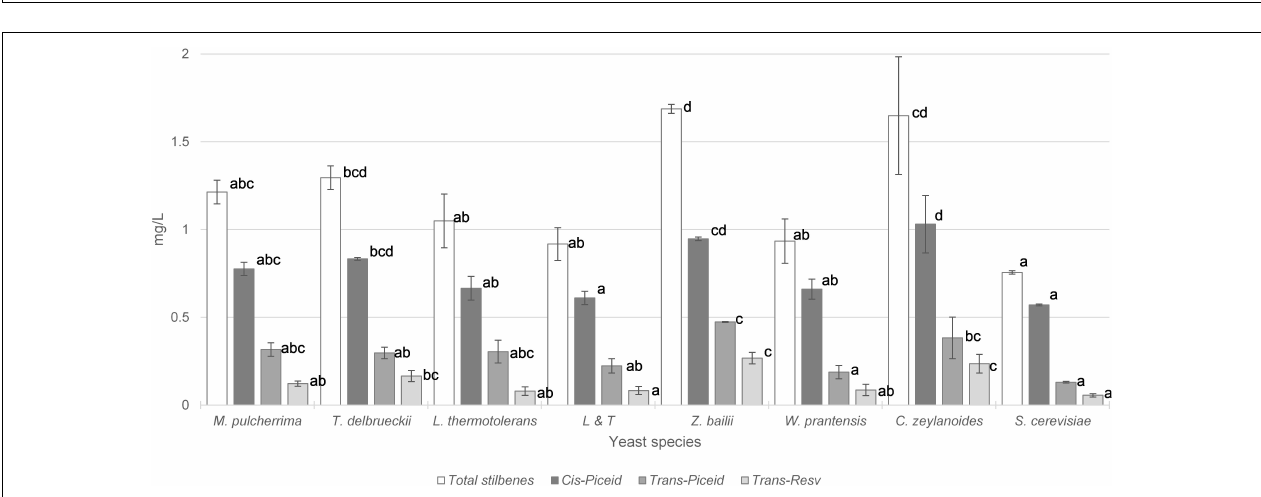
FIGURE 3 | Total stilbene content (mg/L) with the most important groups of stilbenes in wine vinified with different yeasts species. Error bars represent the standard deviation ( n = 2). Different letters mean significant differences between the samples ( p ≤ 0.01). No letters mean no significant